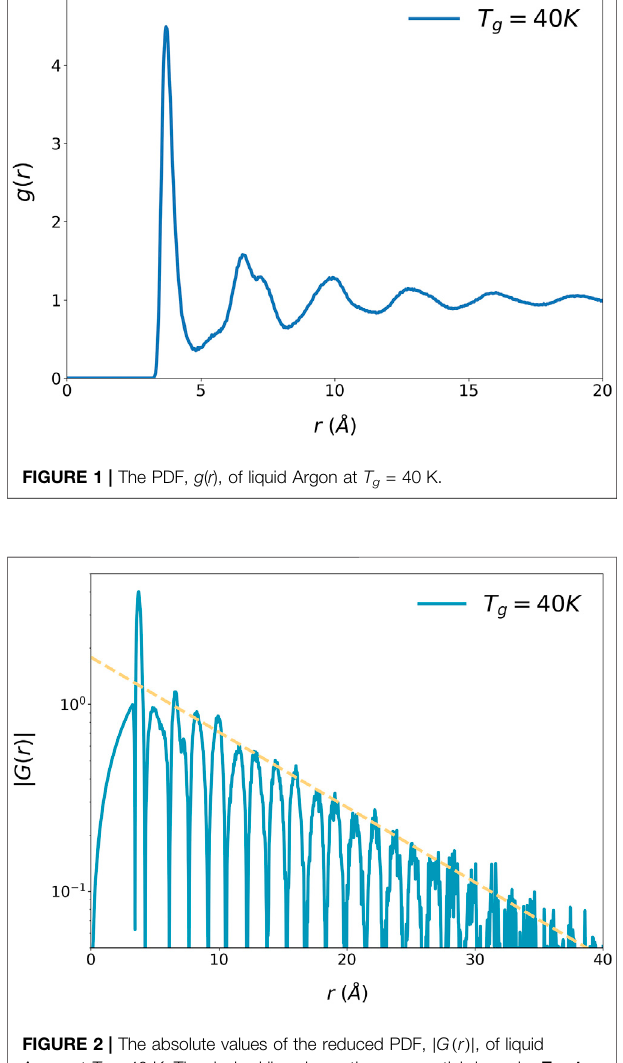
Frontiers in Materials |